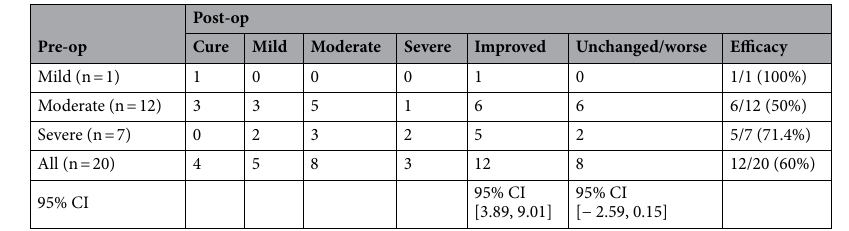
Table 3. Treatment efficacy of PRP injection. PRP, platelet-rich plasma; Pre-op, preoperative; Post-op, postoperative; CI, confidence interval.